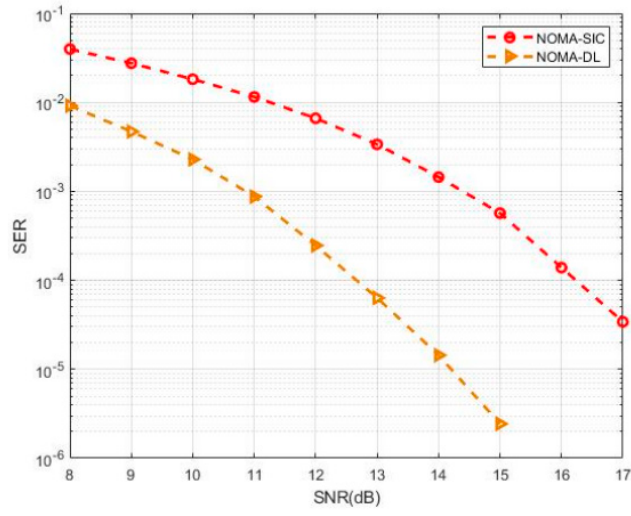
Figure 6. Performance comparison of MIMO-NOMA-DL and MIMO-NOMA-SIC [103].